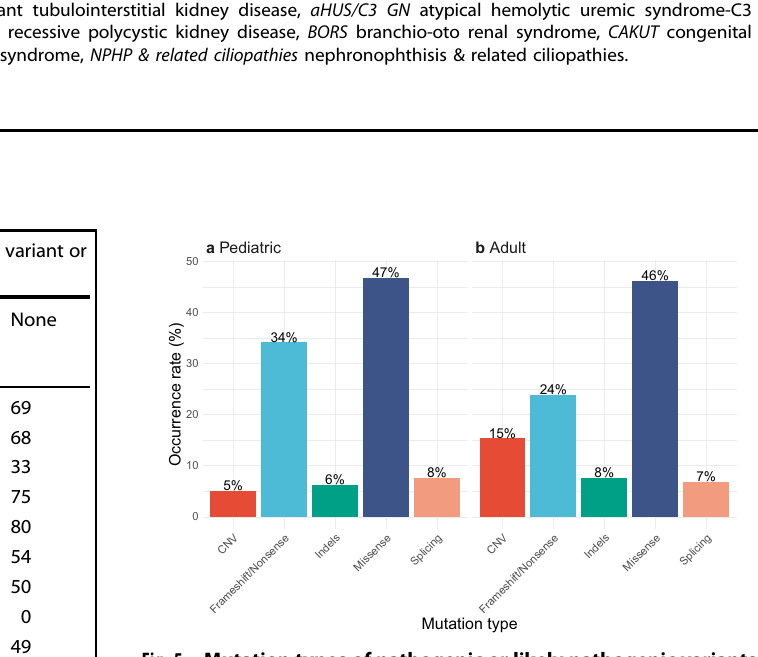
Fig. 5 Mutation types of pathogenic or likely pathogenic variants. a Distribution of mutation types of pathogenic or likely pathogenic variants in the pediatric cohort ( n = 281 probands). b Distribution of mutation types of pathogenic or likely pathogenic variants in the adult cohort ( n = 271 probands). Variant classi fi cation was based on 2015 ACMG guidelines 20 . Abbreviated mutation types are as follows: CNV, copy number variation, indels insertions or panel testing. Nevertheless, pathogenic or likely pathogenic variants were detected most commonly in NPHS1 and NPHS2 while the majority of the variants identi fi ed in the Chinese cohort 3 were found in COQ8B , WT1 , and NPHS1 , illustrating the utility of panels that cater to patients of different ethnic backgrounds. Referrals for the aHUS/C3 GN panel for adult patients were more than three times that for pediatric patients, re fl ecting the higher